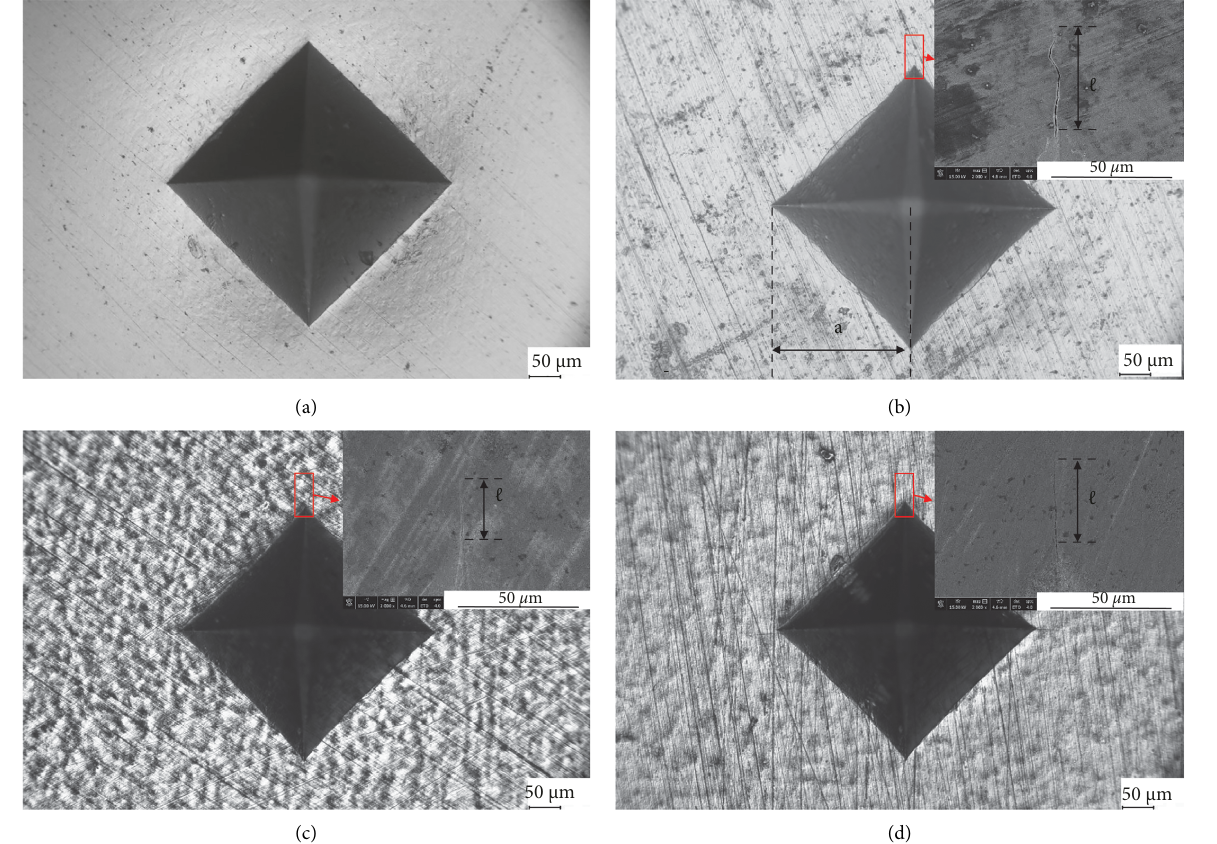
Figure 5: Micrographs of the Vickers indentation and cracks at test loads of 490N. (a) Untreated. (b) Sample A. (c) Sample B. (d) Sample C.